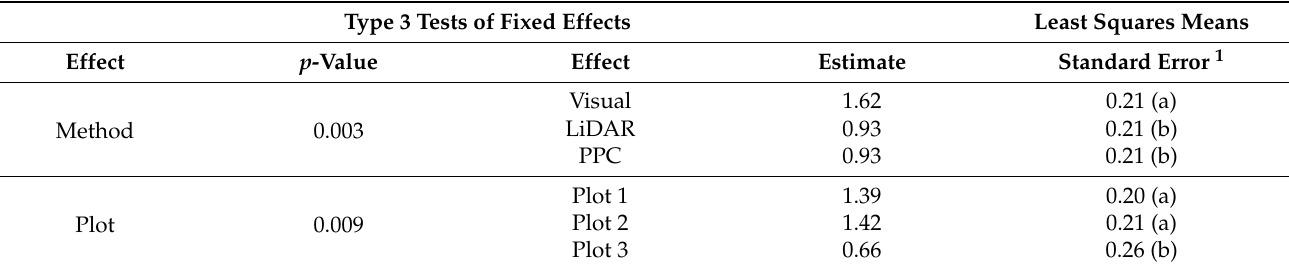
Table 5. Mean total damage count (per tree) comparing visual inventory, handheld LiDAR, and PPC-based methods of assessing tree damage.